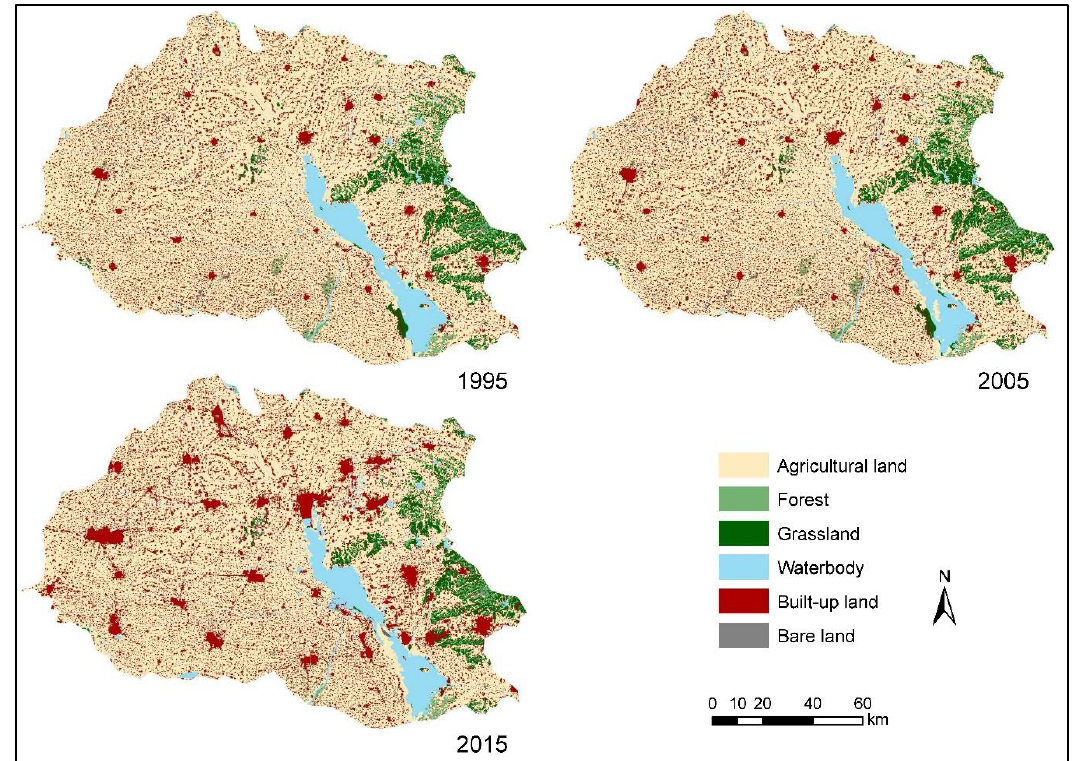
Figure 2. Classification maps of land use in the NLB for 1995, 2005 and 2015.